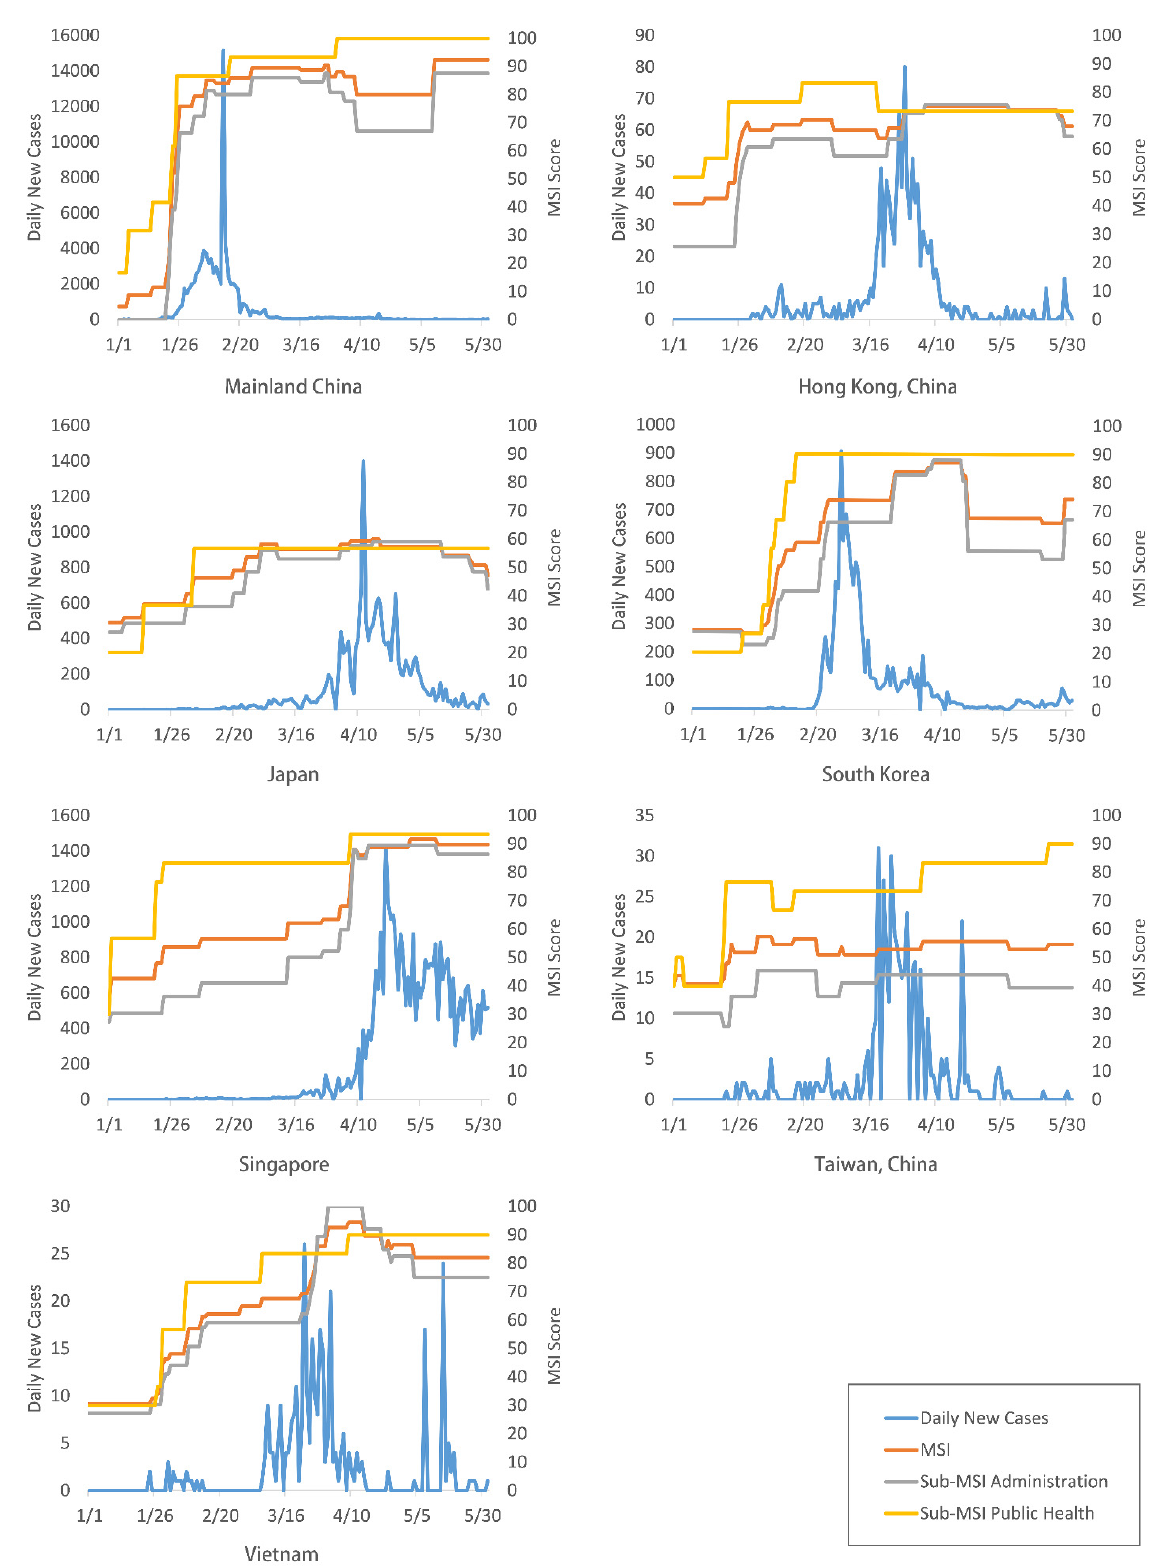
Figure 2. Change of the MSI and sub-MSI relative to disease outbreak in the study sites, 1 January to 30 May 2020. Data sources: ECDC (https://www.ecdc.europa.eu/en/COVID-19/situation-updates (accessed on 1 July 2020)), SSE at JHU (https://github.com/CSSEGISandData/COVID-19/blob/master/README.md (accessed on 1 July 2020)).